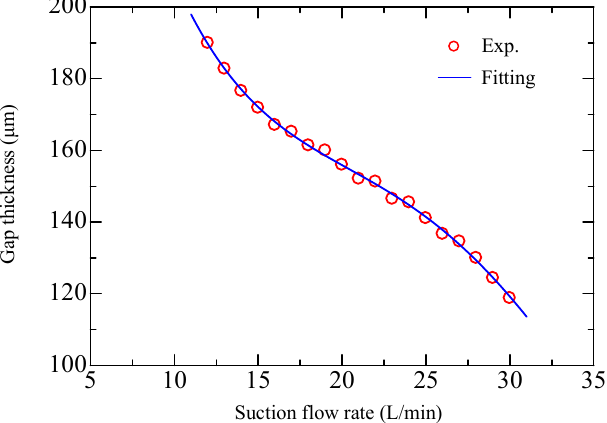
Figure 8. Gap thickness versus suction flow rate.